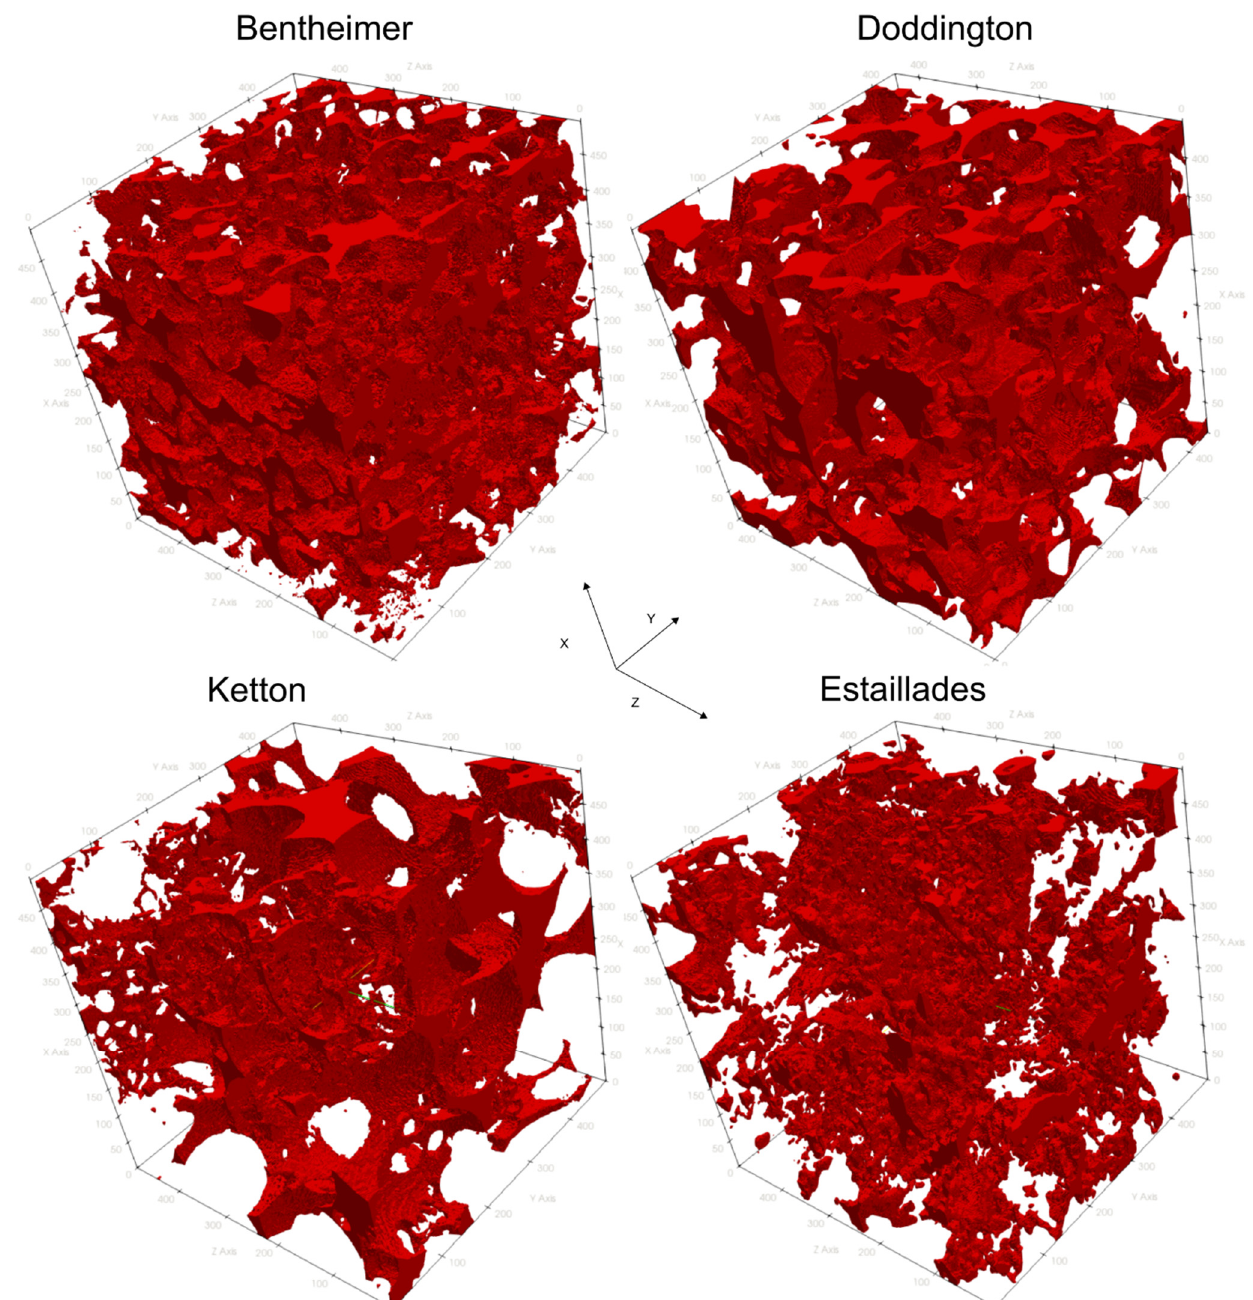
Figure 8. The four analysed digitalised rock samples downloaded from https://www.imperial.ac.uk/earth-science/research/research-groups/pore-scale-modelling/micro-ct-images-and-networks/ (accessed on 27 July 2021). The images represent a 500 × 500 × 500 subset, processed using a threshold filter. Red colour represents the solid matrix.